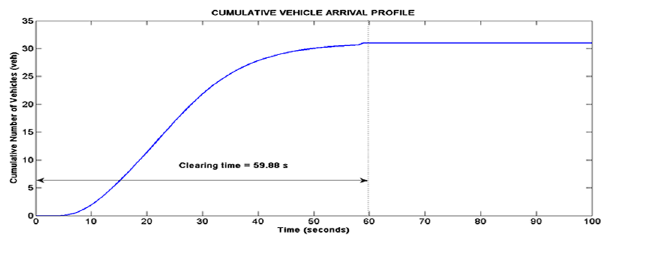
Fig 9. Arrival profile of platoon A.